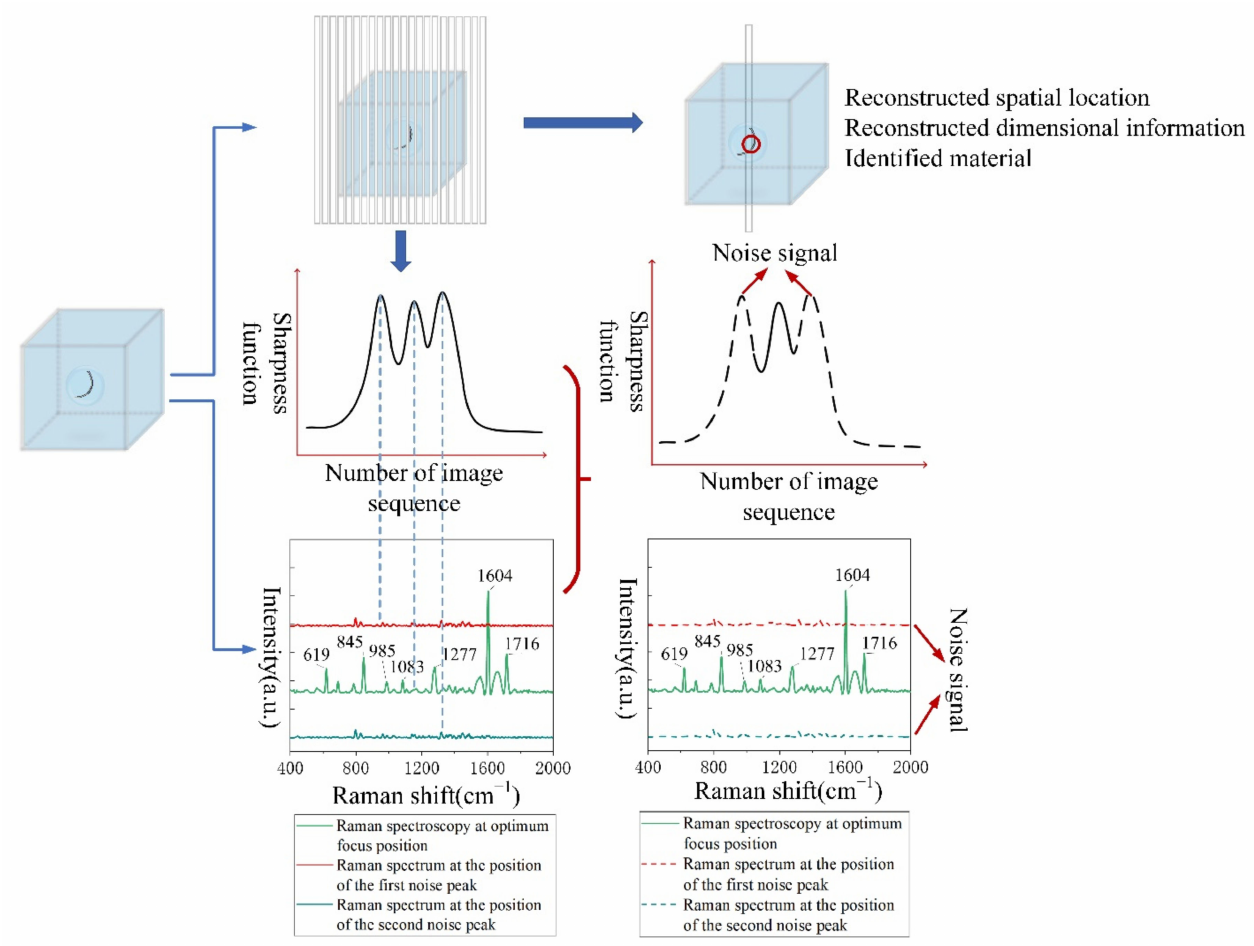
Figure 2. Schematic diagram of cross validation between the sharpness function signal of autostereo- scopic method and Raman spectrum